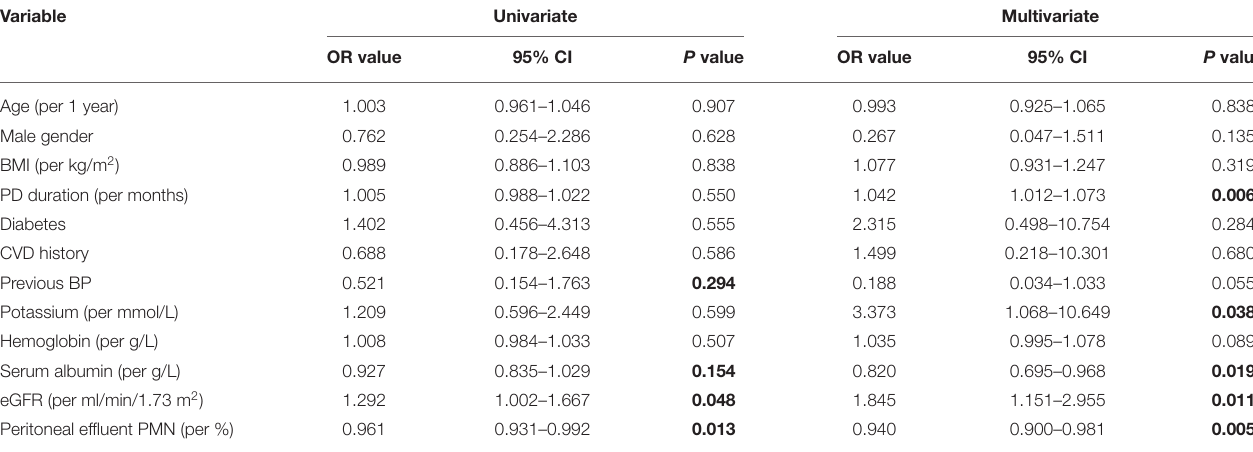
TABLE 5 | Univariate and multivariate logistic regression analysis for risk factors of